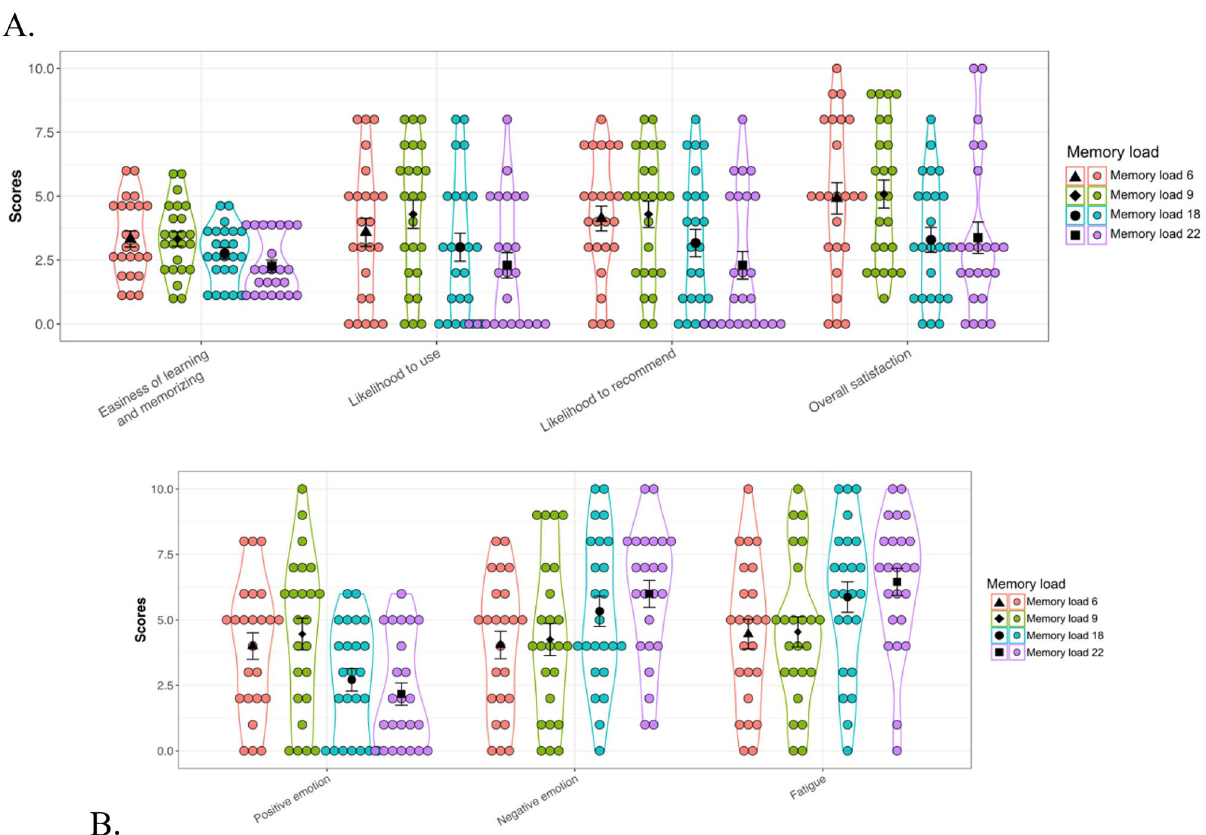
Figure 5. Mean rating scores of gesture evaluations ( A ) and emotions and fatigue ( B ). Black triangles, diamonds, dots and squares represent mean scores of subjective ratings in the memory load 6, 9, 18 and 22, receptively. Jittered dots in red, green, blue and purple are individual rating scores in the memory load 6, 9, 18 and 22, respectively. Error bars indicate the standard error of the